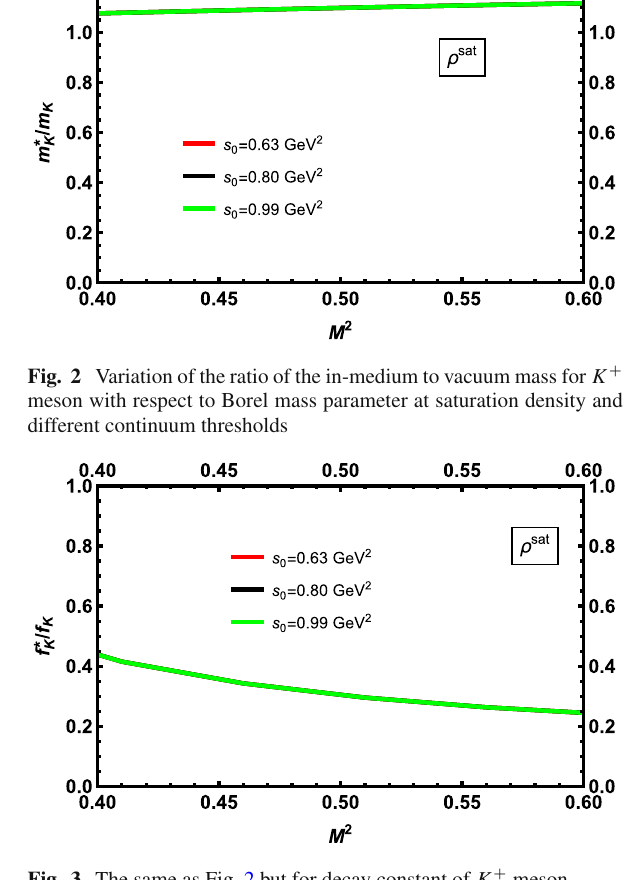
Fig. 3 The same as Fig. 2 but for decay constant of K + meson